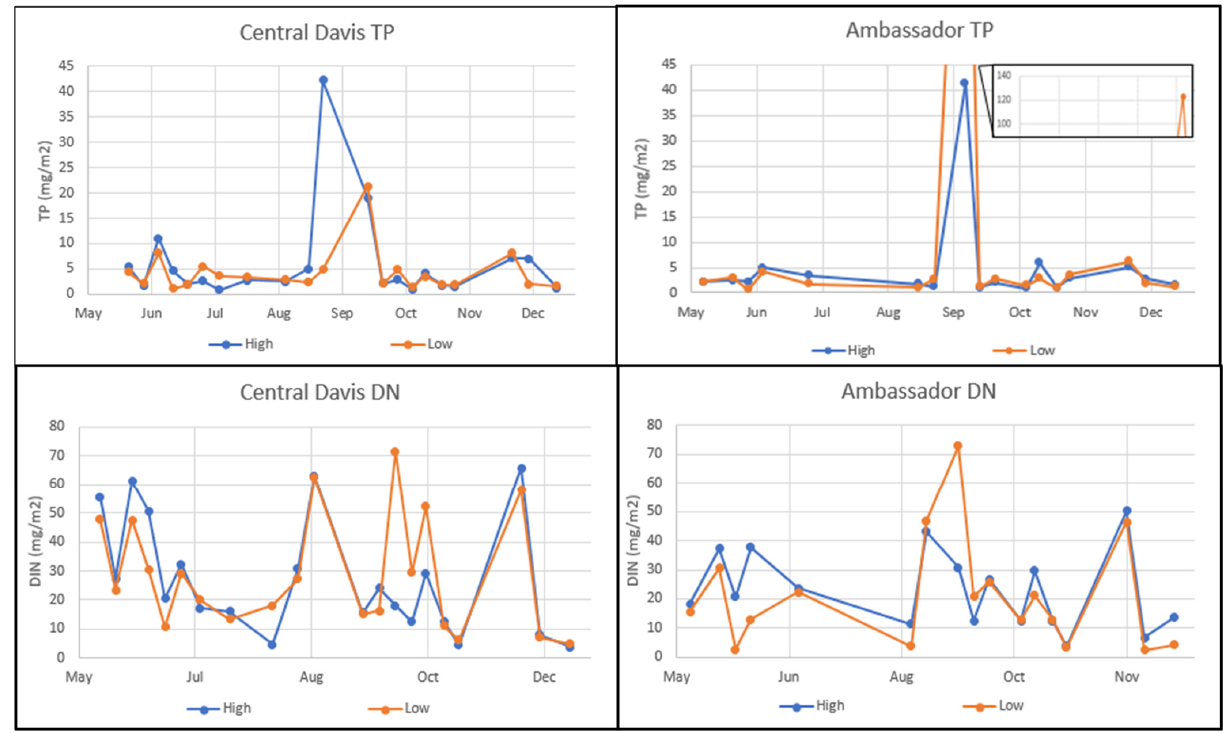
Figure 8. A graphical comparison of TP data ( top panel) and DIN data ( bottom panel) collected over 8 months from paired high and low tables at two different sites, Central Davis and Ambassador, in the left and right panels, respectively. We did not remove any outliers from these data.